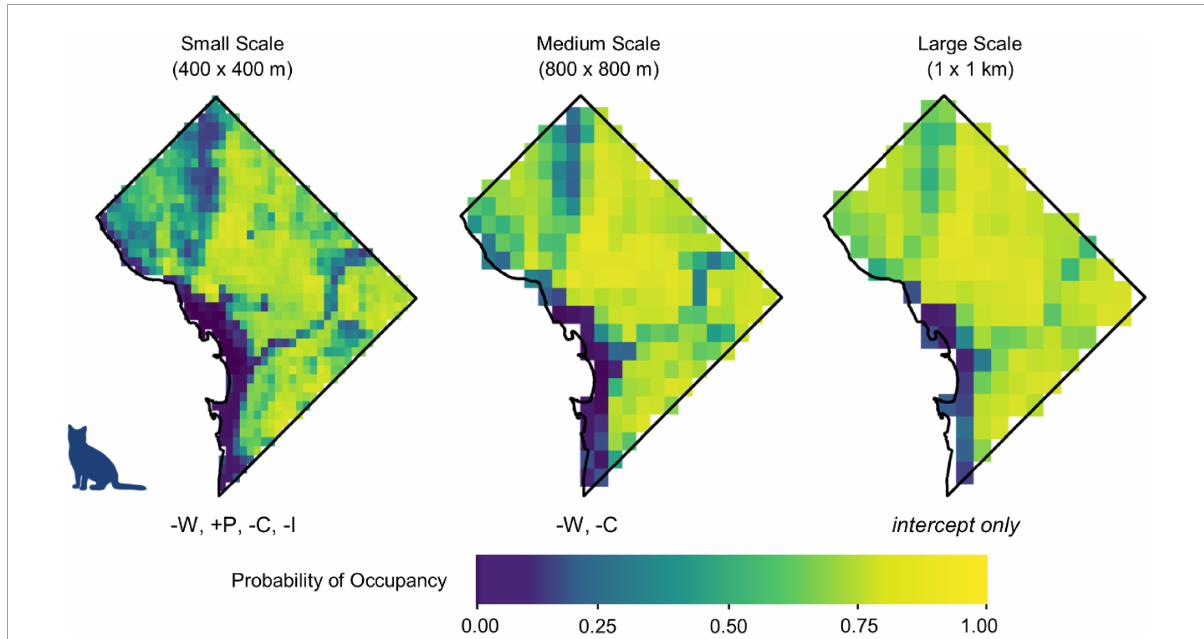
FIGURE3 Occupancy probabilities for domestic cats across Washington, DC, at three spatial scales using the mean posterior value for each parameter. Cooler colors signify lower occupancy probability, while warmer colors signify higher occupancy probability. Initials below each map denote the variables whose 95% credible interval did not overlap zero, in their order of magnitude (W = water, C = canopy cover, P = human population density, I = per capita income, T = traffic). A positive sign preceding each initial signifies a positive relationship, while a negative sign signifies a negative relationship. Maps show predicted occupancy using the median value for each parameter. Maps depicting predicted occupancy at the upper and lower limits of the 95% credible interval are available in Supplementary Appendix 4